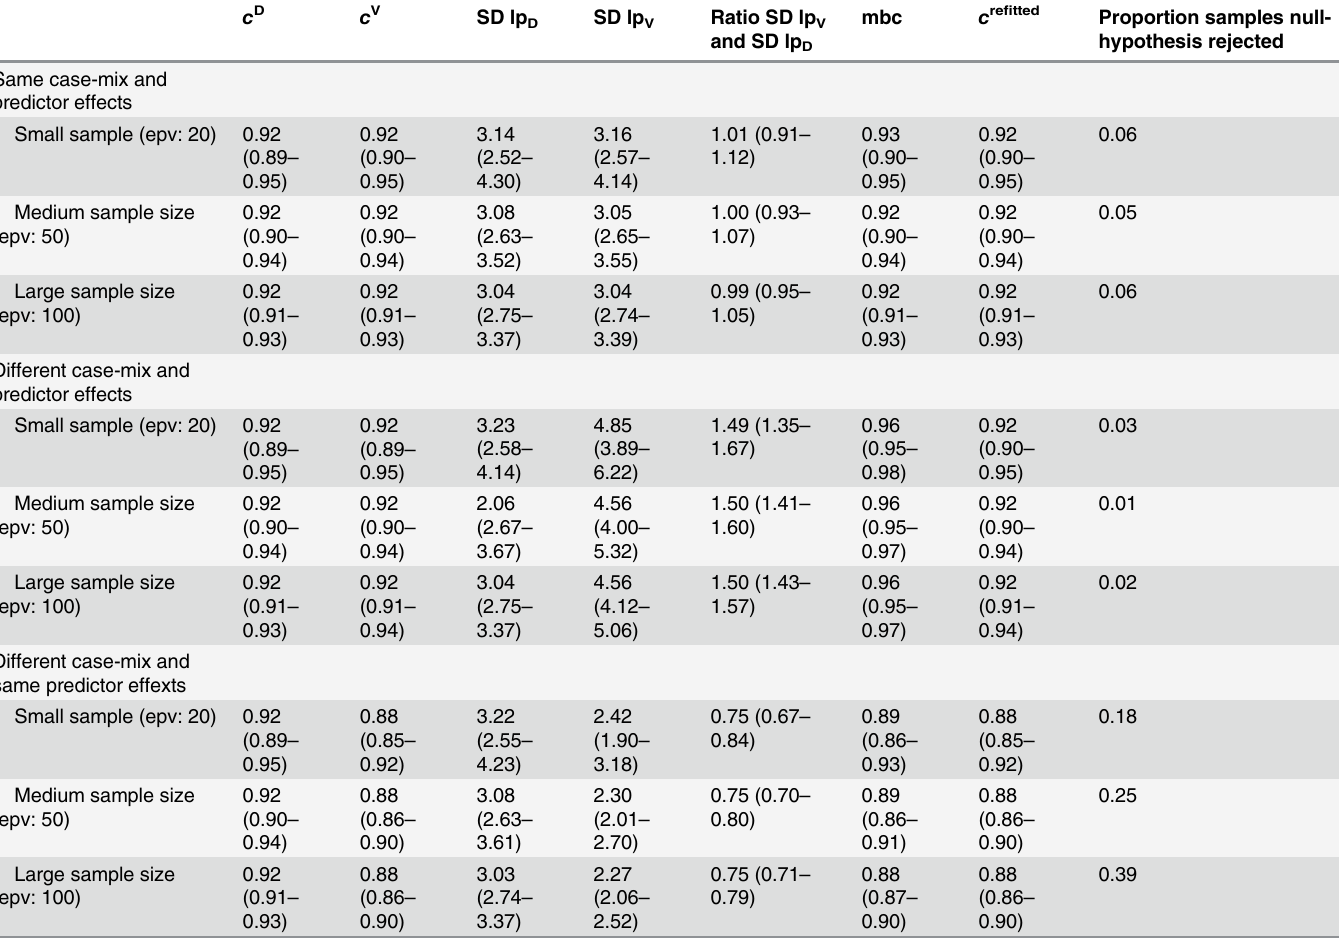
Table 2. Results from the simulation study, median and inter-quartile range of 1000 simulations is shown for c -statistics and standard deviations. Proportion of samples where the permutation test rejected the null hypothesis is shown. c D c V SD lp D SD lp V Ratio SD lp V and SD lp D